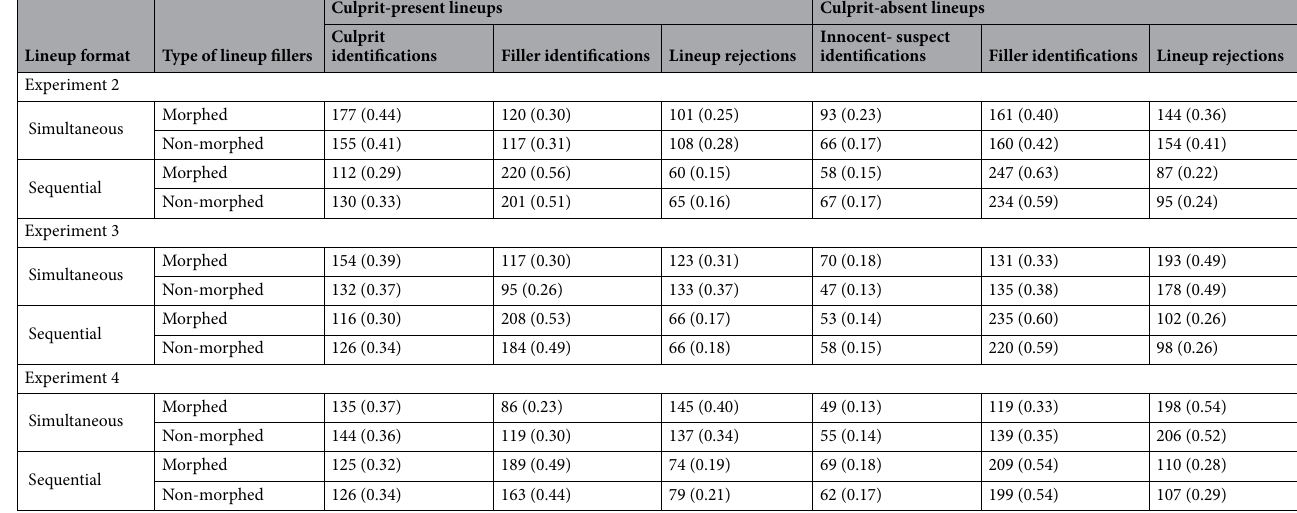
Table 1. Observed response frequencies and proportions (in parentheses) as a function of lineup format and the type of lineup fillers observed in Experiments 2, 3 and 4. The proportions are rounded to two decimal places and therefore do not always add up exactly to